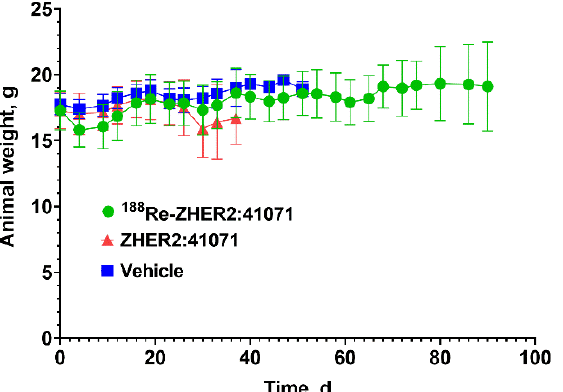
Figure 12. The average body weight of mice after treatment with 188 Re-ZHER2:41071 (three times with 5 µg, 16 MBq, dissolved in 10% ethanol in 0.9% saline), non-labeled ZHER2:41071 (three times with 5 µg, dissolved in 10% ethanol in 0.9% saline), and vehicle (three times with 10% ethanol in 0.9% saline).